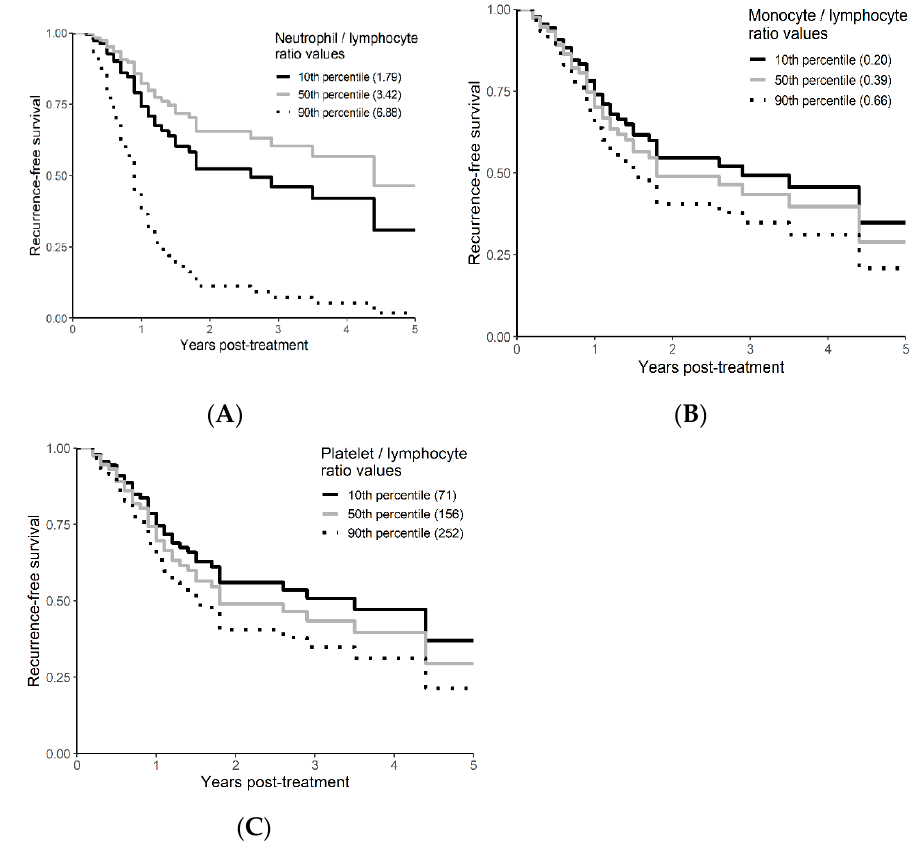
Curr. Oncol. 2022 , 29 Figure 5. Kaplan–Meier curves for RFS by NLR ( A ), MLR ( B ), and PLR ( C ) using predicted values at the 10th, 50th, and 90th percentile of predictors.